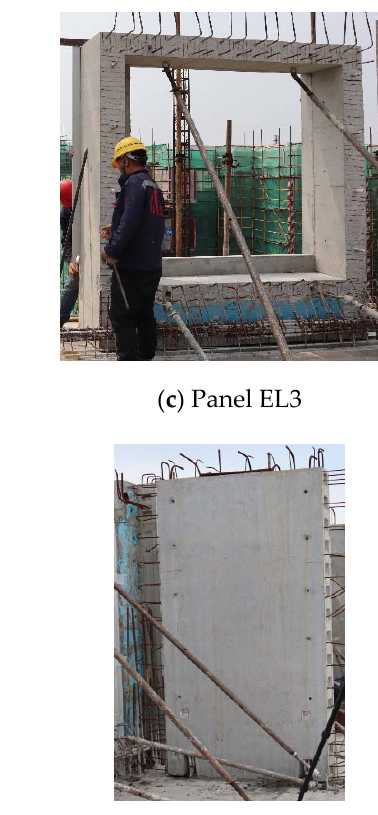
Figure 8. Images of internal (IL) PWPs and external (EL) PWPs.